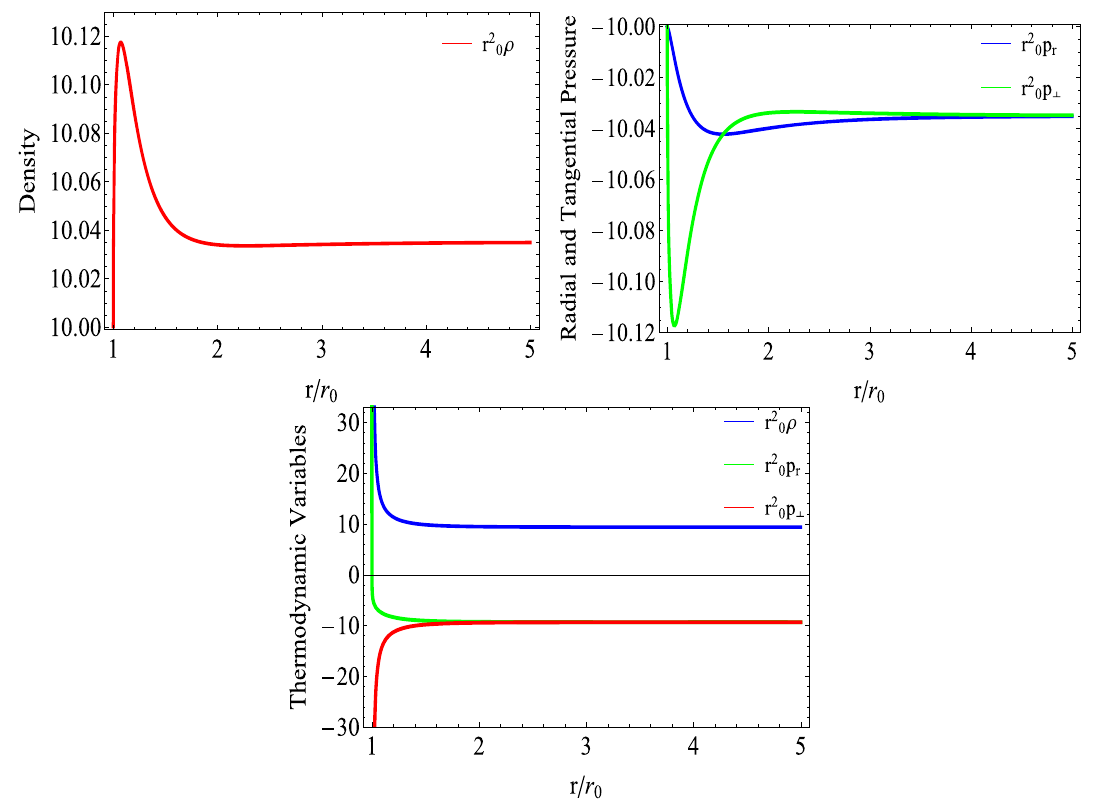
Fig. 3 Upper row: ( m = 0) The dimensionless density and radial and tangential pressure against the ratio r / r 0 . Lower row: ( m = 1) The trend of the dimensionless thermodynamic variables versus the dimensionless radial coordinate r / r 0